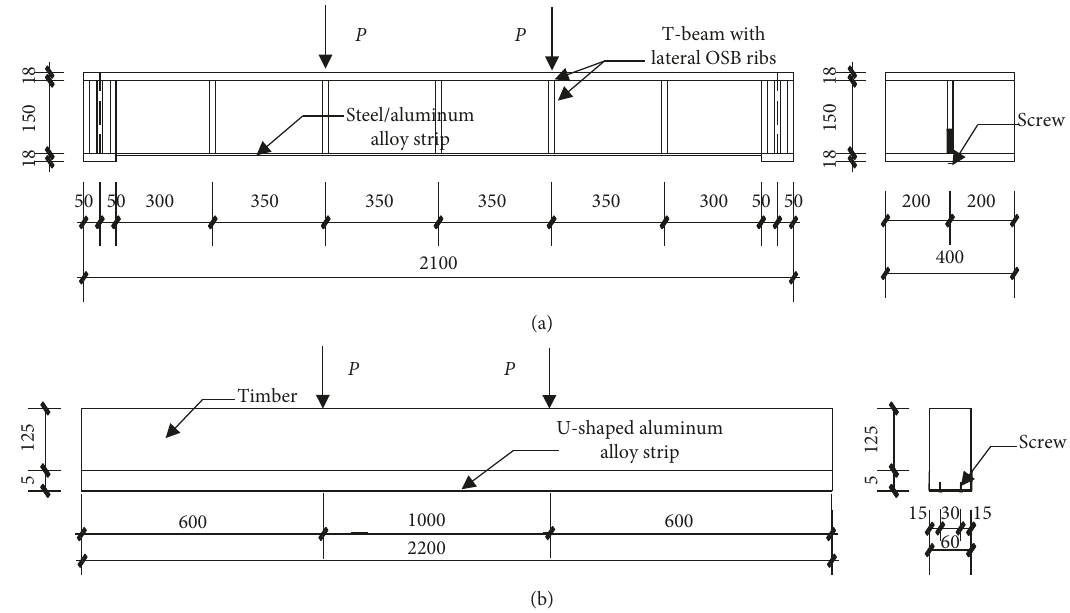
Figure 6: General view of the test: (a) SU-OT beam (mm) [44] and (b) AU-T beam (mm).